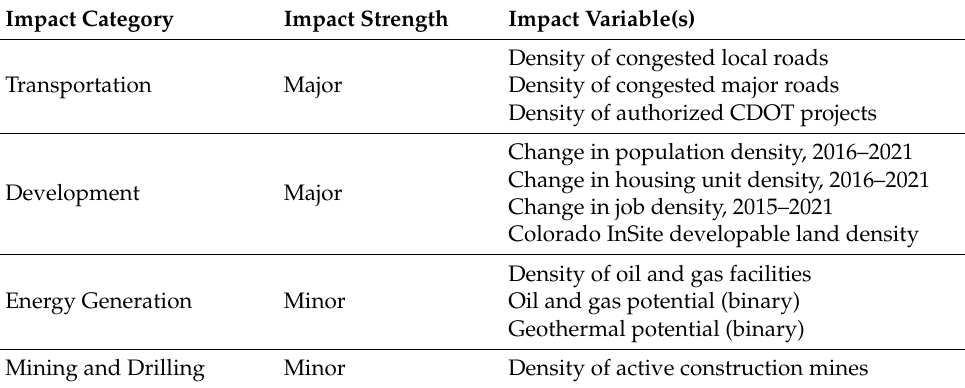
Table A3. Characterizing future demand for stream mitigation based on